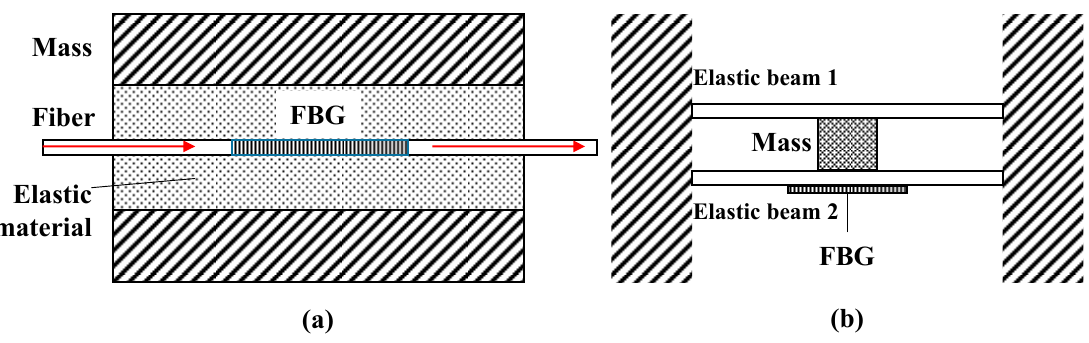
Figure 17. FBG-based accelerometer: ( a ) elastic material and ( b ) two simply supported beams. FBG has good multipoint measurement capability. Linze et al. designed a distributed optical accelerometer based on FBG [81,82]. This distributed optical accelerometer is realized by using pairs of vibration-sensitive mechanical structures and paired FBGs with different Bragg wavelengths. In the design of Linze et al., up to six optical accelerometers can be combined for measurement.